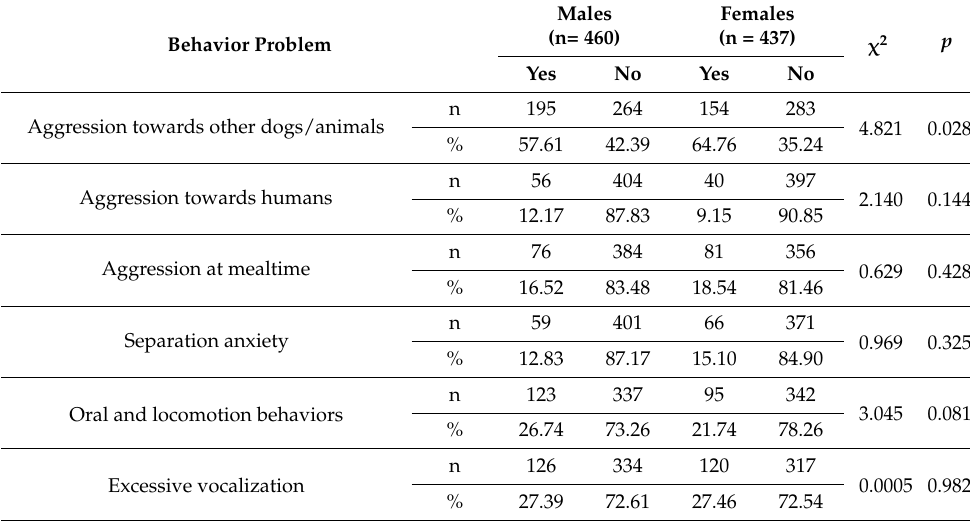
Table 3. The influence of sex on the incidence of undesirable behaviors in ancient dog